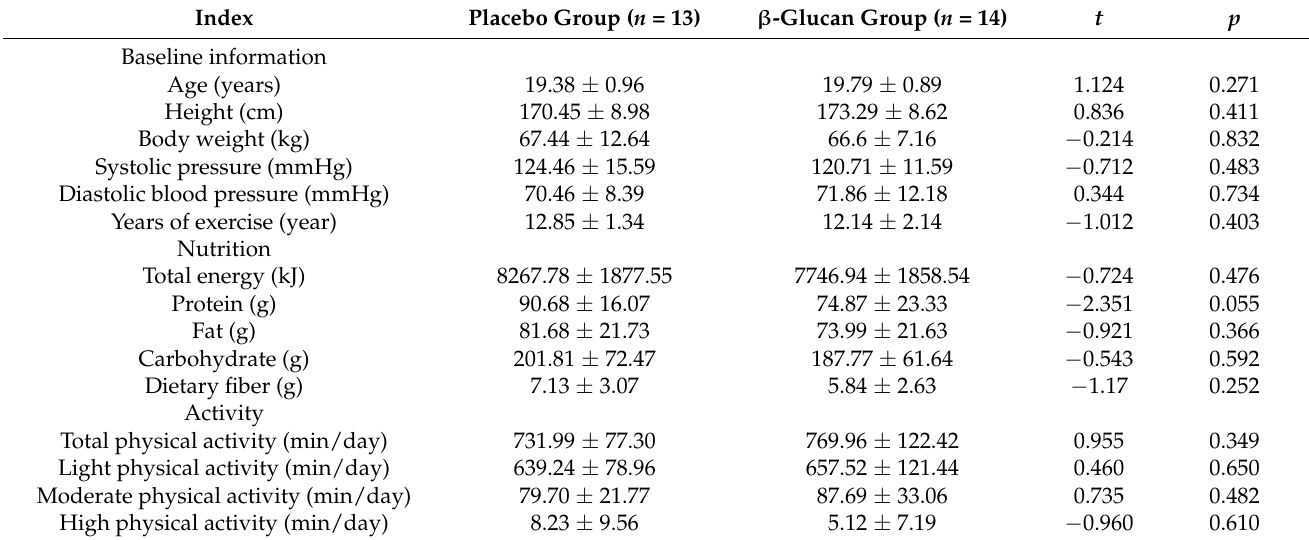
Table 1. Baseline characteristics of experimental groups.